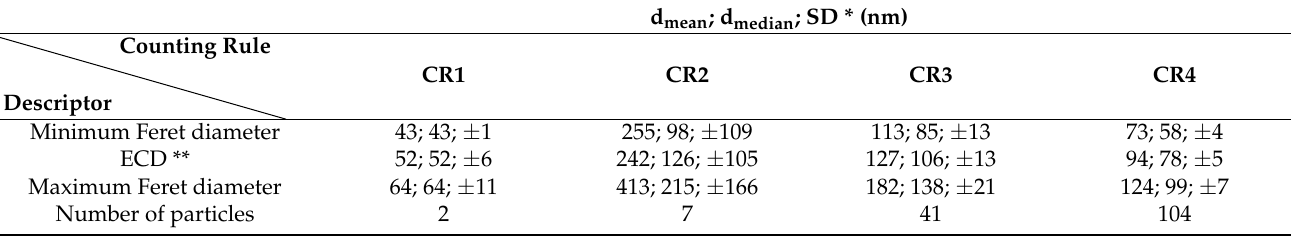
Table 3. Comparison of descriptor values and results when applying the Counting Rules to the TEM micrograph of zinc oxide shown in Figure 6. The numbers are obtained assuming a lognormal distribution. See Figures S1–S3 for details of the corresponding particle size